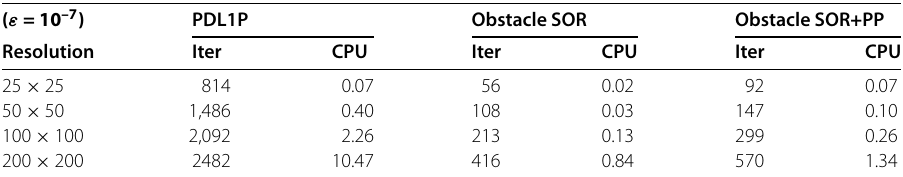
Table 5 CPU time and iteration comparisons for the suggested post-process, applied to the linear problem with ϕ = ϕ 2 ( ε = 10 –7 ) PDL1P Obstacle SOR Obstacle SOR + PP Resolution Iter CPU Iter CPU Iter CPU